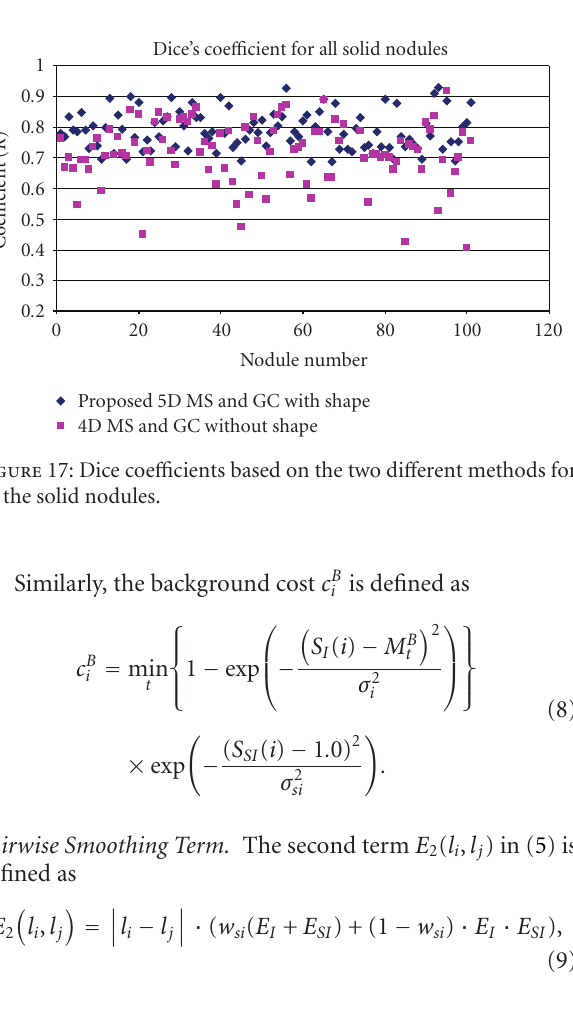
Figure 16: Example of di ff erent types of solid nodules. (a) Isolated nodules; (b) vascular nodules; (c) pleural nodules.